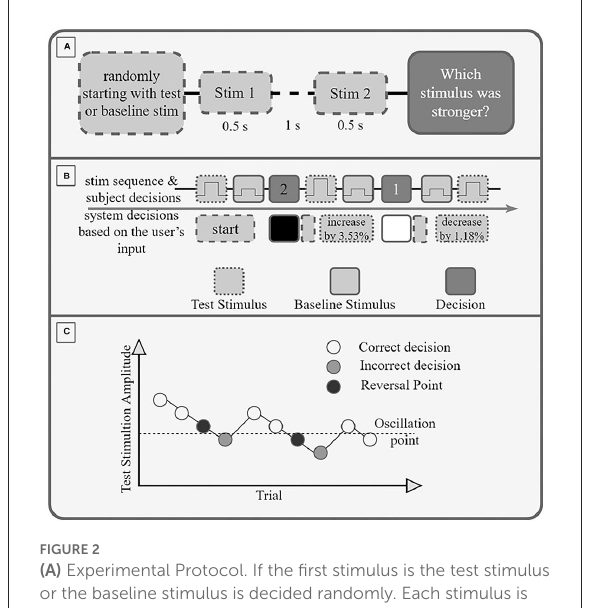
FIGURE2 (A) Experimental Protocol. If the first stimulus is the test stimulus or the baseline stimulus is decided randomly. Each stimulus is 0.5s long, and between the stimuli is a break of 1s. After the second stimulus, the participant must decide (and select via the joystick) if the first or second stimulus had a higher amplitude (was stronger). (B) Exemplary sequence of trials. A wrong decision increases the amplitude of the test stimulus by 3.53%, a correct decision decreases it by 1.18%. (C) Exemplary Staircase sequence. The amplitude of the stimulation is reduced after each correct decision and increased after an incorrect decision. A reversal point is the last correctly recognized amplitude before an incorrect decision. The oscillation point is the average amplitude of 10 reversal